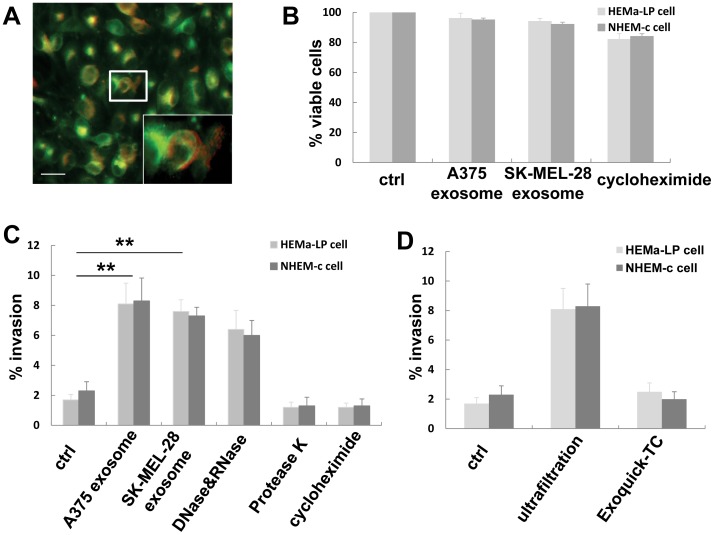
Melanoma exosomes are taken up by normal melanocytes and conferred invasion ability on normal melanocytes.(A) HEMa-LP cells and A375 exosomes were labeled using the green fluorescent dye PKH67 and the red fluorescent dye PKH26 respectively. After incubating the labeled A375 exosomes with HEMa-LP cells for 24 h, confocal microscopy images were taken (magnification, x600). The overlay image shows A375 exosomes (red) were internalized by HEMA-LP cells (green). The insert represents higher magnification of the boxed area (scale bar = 20 µm). (B) MTT assay of HEMa-LP and NHEM-c cells incubating with media only (control), A375 exosomes, SK-MEL-28 exosomes, and cycloheximide. (C) Percent invasion of HEMa-LP and NHEM-c cells after incubation of 5 days with A375 exosomes, SK-MEL-28 exosomes, pretreatment of DNase and RNase A with A375 exosomes, pretreatment of Protease K with A375 exosomes, and treatment of A375 exosomes with cycloheximide. (D) Comparison of percent invasion in HEMa-LP cells and NHEM-c cells using exosomes isolated by a combination of ultrafiltration and ultracentrifugation and by Exoquick-TC precipitation. Each invasion assay experiment was performed in triplicate, and data from three independent experiments are presented. (**p<0.01, significant in comparison with control).